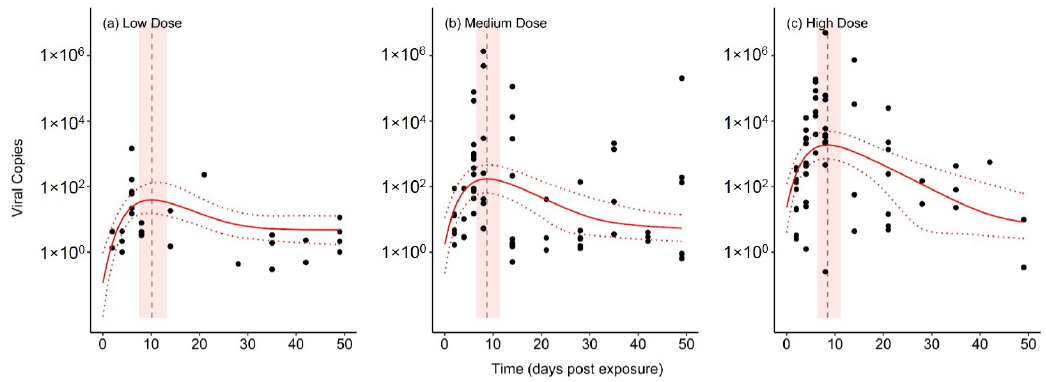
Figure 1. The fit of model B2 to the experimental data. Circles are data points representing the viral DNA copies from individual bullfrog tadpoles that were sampled on a given day. The median model fit (solid red line) and 95% Bayesian credible interval (CI) of the fit (dashed red lines) are shown. Additionally, the median (dashed vertical line) and 95% CI (light red polygon) are shown for the time of the maximum viral titer predicted by the